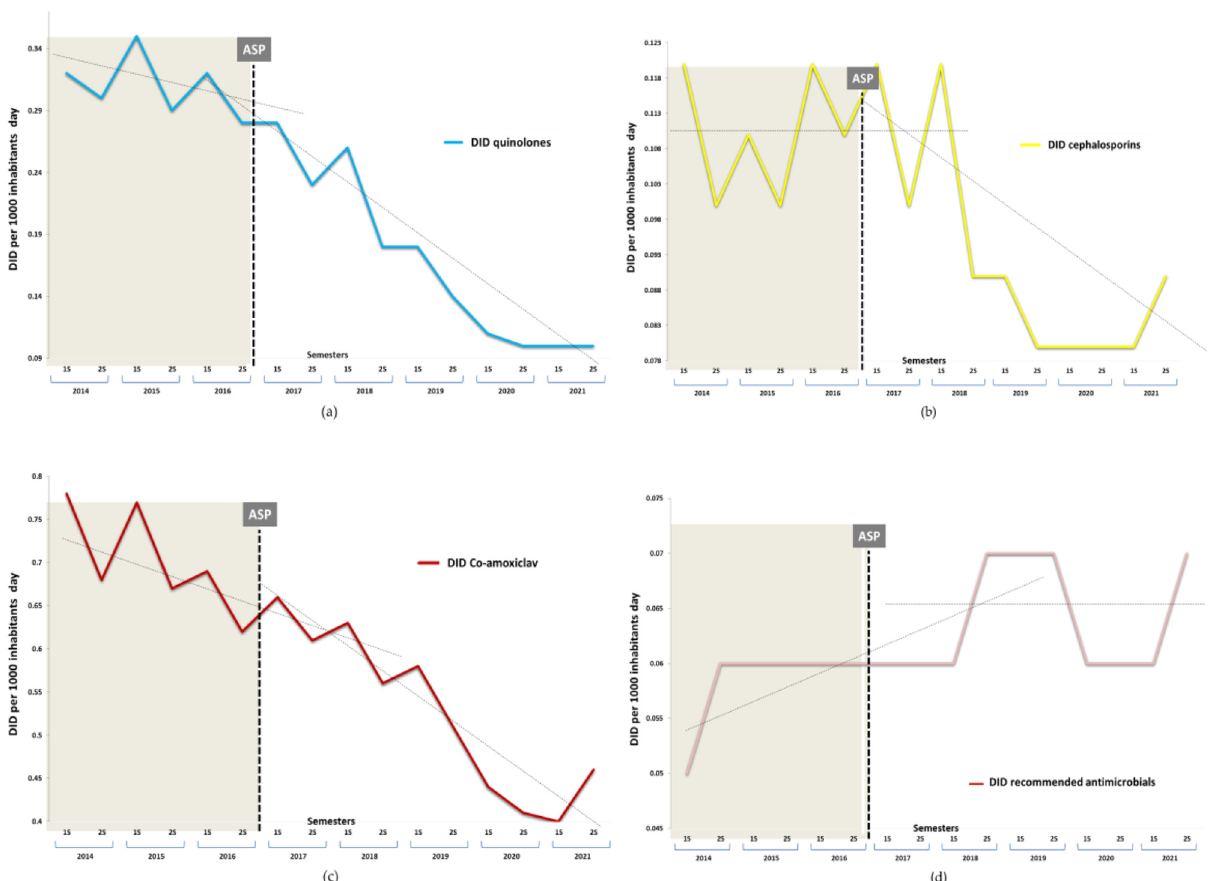
Figure 3. Semestral evolution of defined daily doses per 1000 inhabitants/day (DID). ( a ) Quinolones, ( b ) cephalosporins, ( c ) co-amoxiclav, ( d ) recommended antimicrobials: fosfomycin trometamol, ni- trofurantoin.